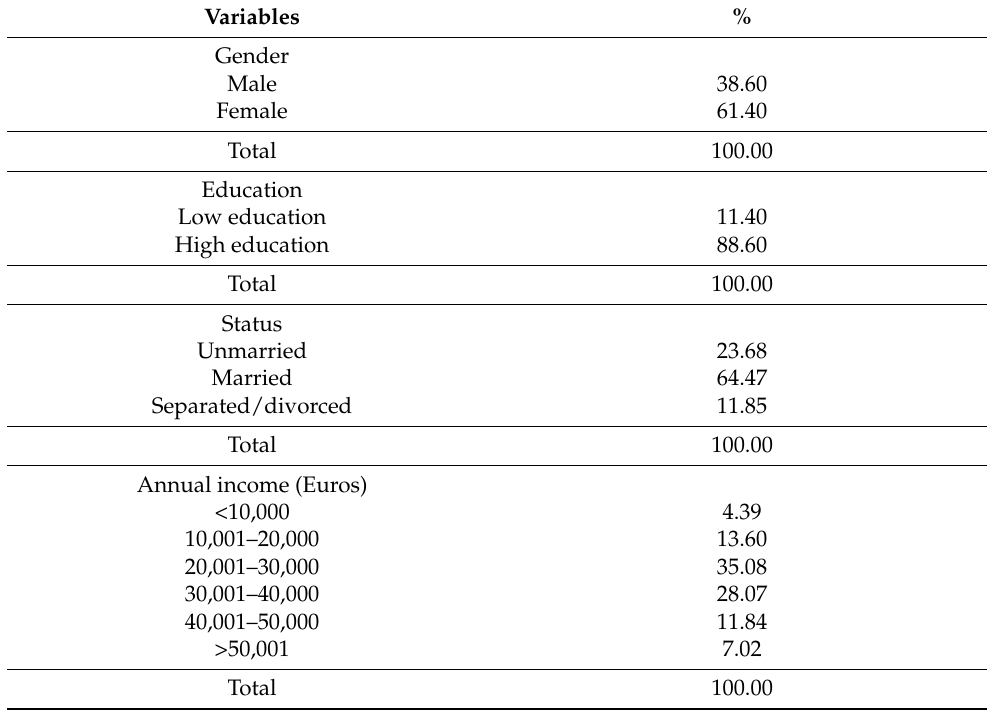
Table 1. Socioeconomic and demographic characteristics of the sample ( n =